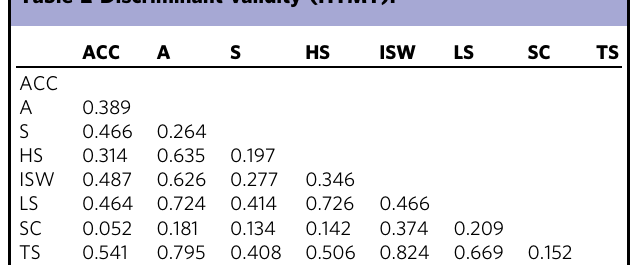
Table 1 Measurement model. Table 2 Discriminant validity